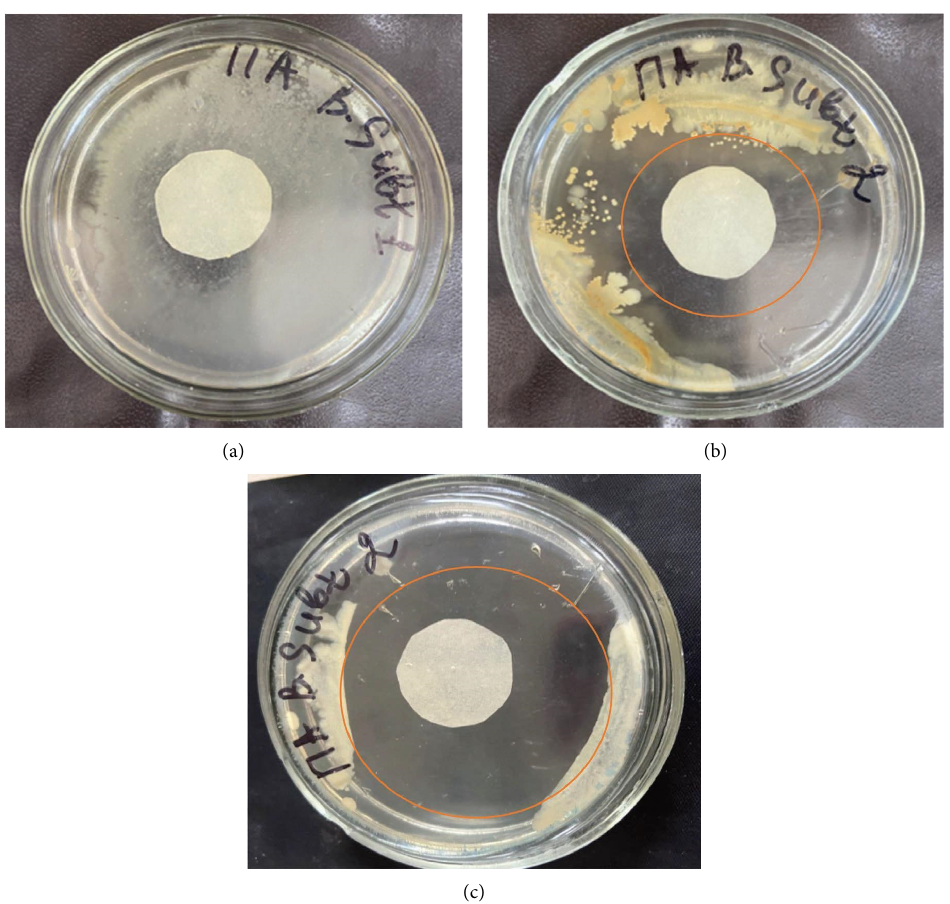
Figure 9: Antibacterial activity of “green” synthesized AgNPs via agar disk difusion by Gram-positive bacteria Bacillus subtilis : (a) distilled water, (b) synthesized AgNPs with grape pomace extract obtained by P-GPE, and (c) antibiotic (aztreonam).